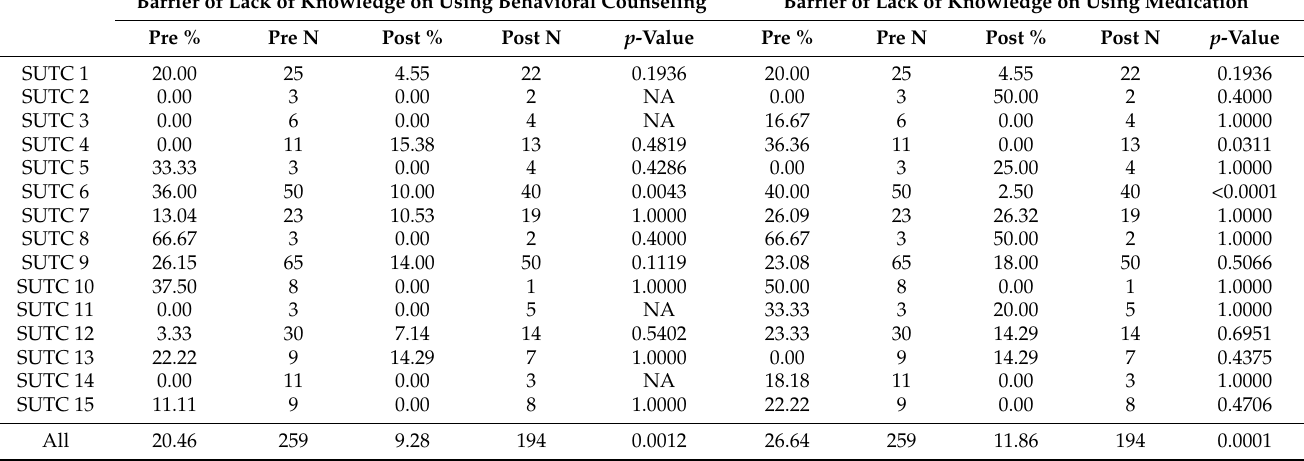
Table 1. Changes in providers’ perceived lack of knowledge barriers for tobacco cessation care provision from pre-to post-implementation of a comprehensive tobacco-free workplace